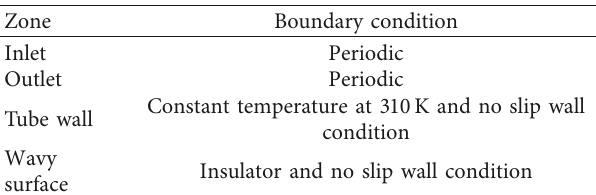
Table 1: Boundary condition for the computational domain of the heat exchanger tube equipped with the V-wavy surface.